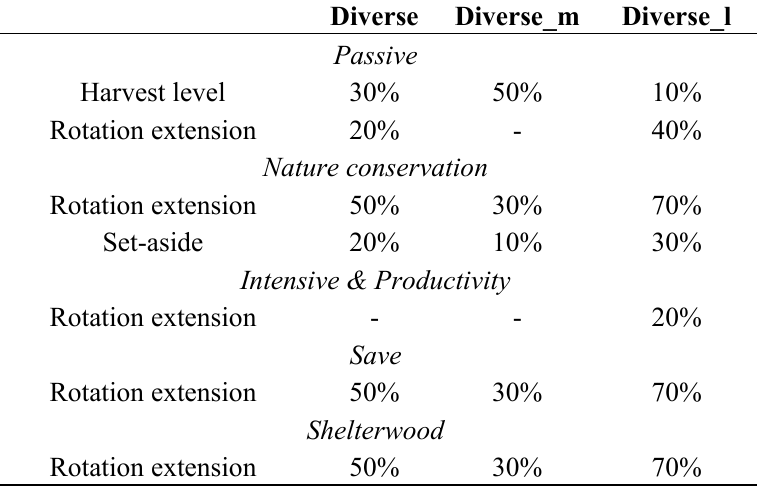
Table 7. Model parameters for the Diverse scenario and its alternatives for the sensitivity analysis: more intensive management (Diverse_m) and less intensive management